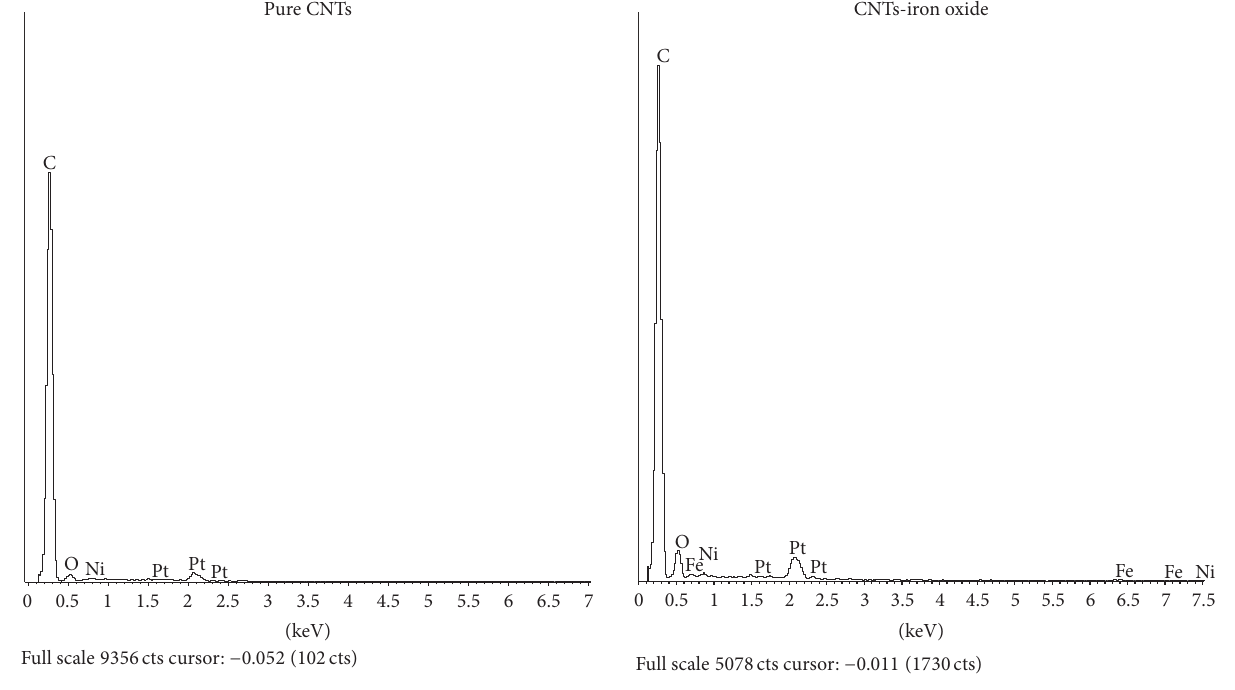
Figure 2: EDX analysis of pure and iron oxide impregnated CNTs.